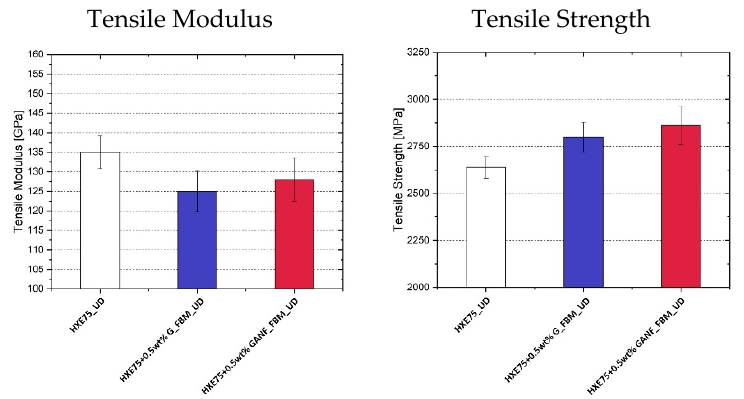
Figure 10. Tensile test results of the composites under examination.